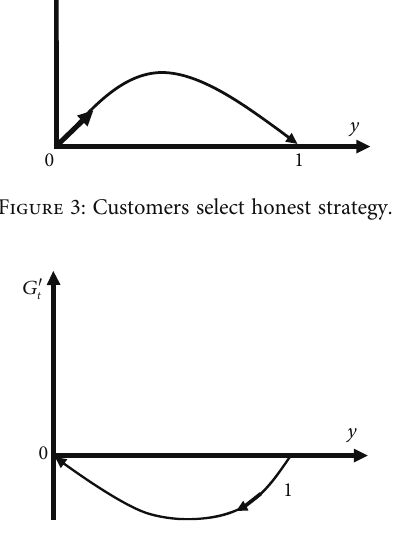
Figure 4: Customers select dishonest strategy.